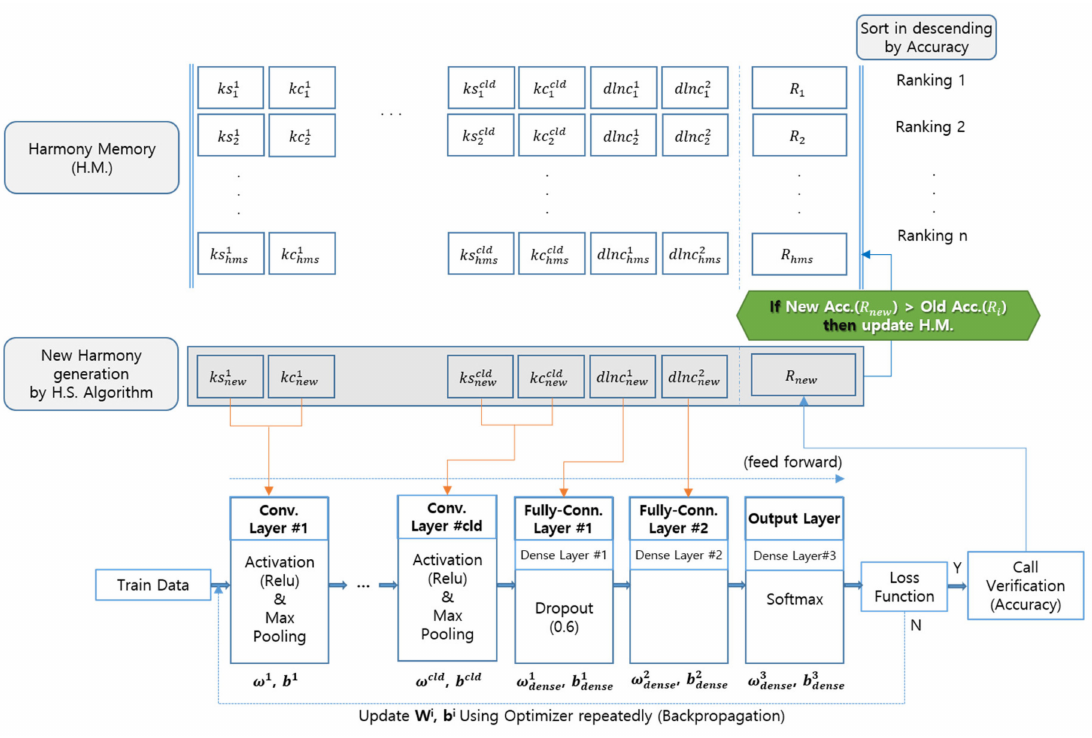
Figure 5. Process for hyperparameter optimization between HM and 1D